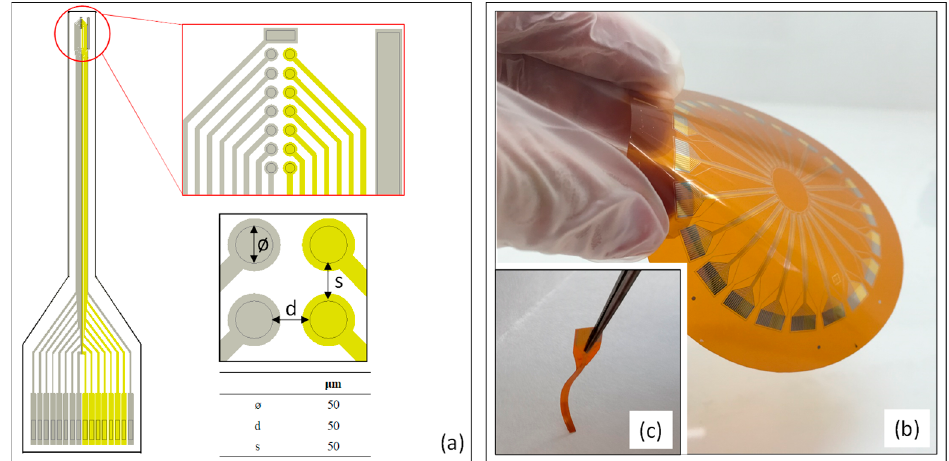
Figure 1. ( a ) Microsensor design diagram, consisting of 2 arrays of 7 disk electrodes fabricated in gold and in platinum, and an integrated pRE and CE. Details of the arrangement of the two arrays and corresponding diameter of the electrodes, the distance between them, and the distance between the two arrays. ( b ) A flexible polyimide multi-analyte sensor fabricated on a flexible Kapton ® substrate at